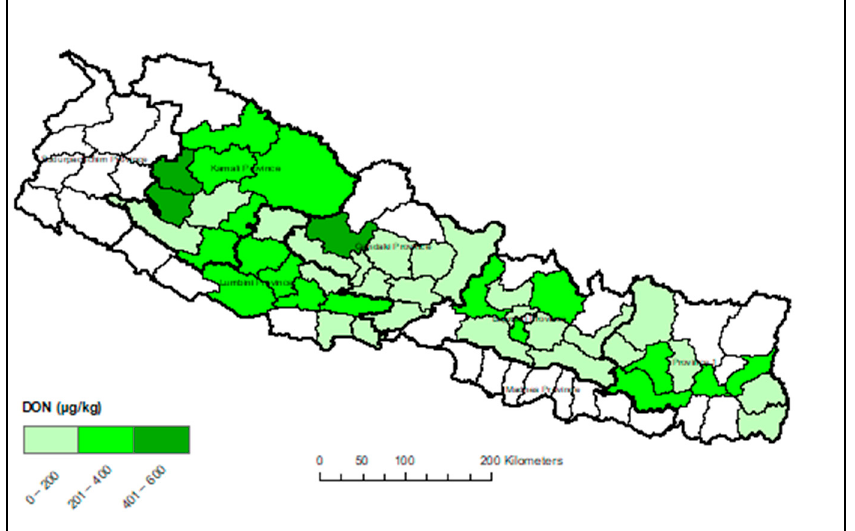
Figure A1. Heat map of DON occurrence in Nepalese maize. The range of found concentration of DON is shown in light green, green and dark green colors, representing the concentrations ranging from low to high. DON was found in concentrations of 110 to 520 µg/kg.